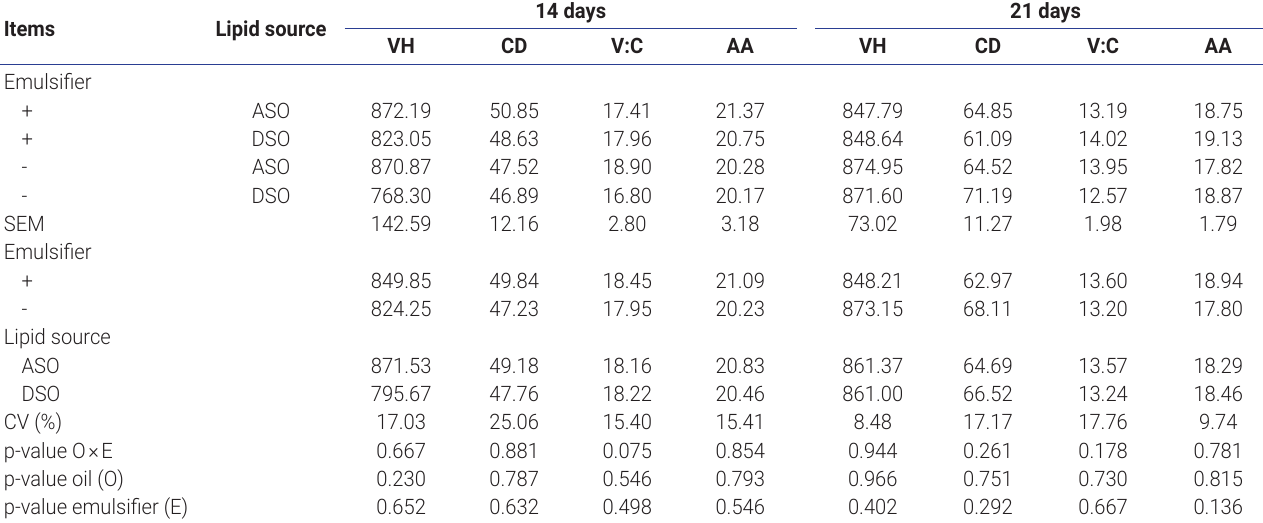
Table 7. Villus height, crypt depth, villus:crypt ratio, and area of absorption of duodenum of broilers fed diets containing different lipid sources, with or without emulsifier